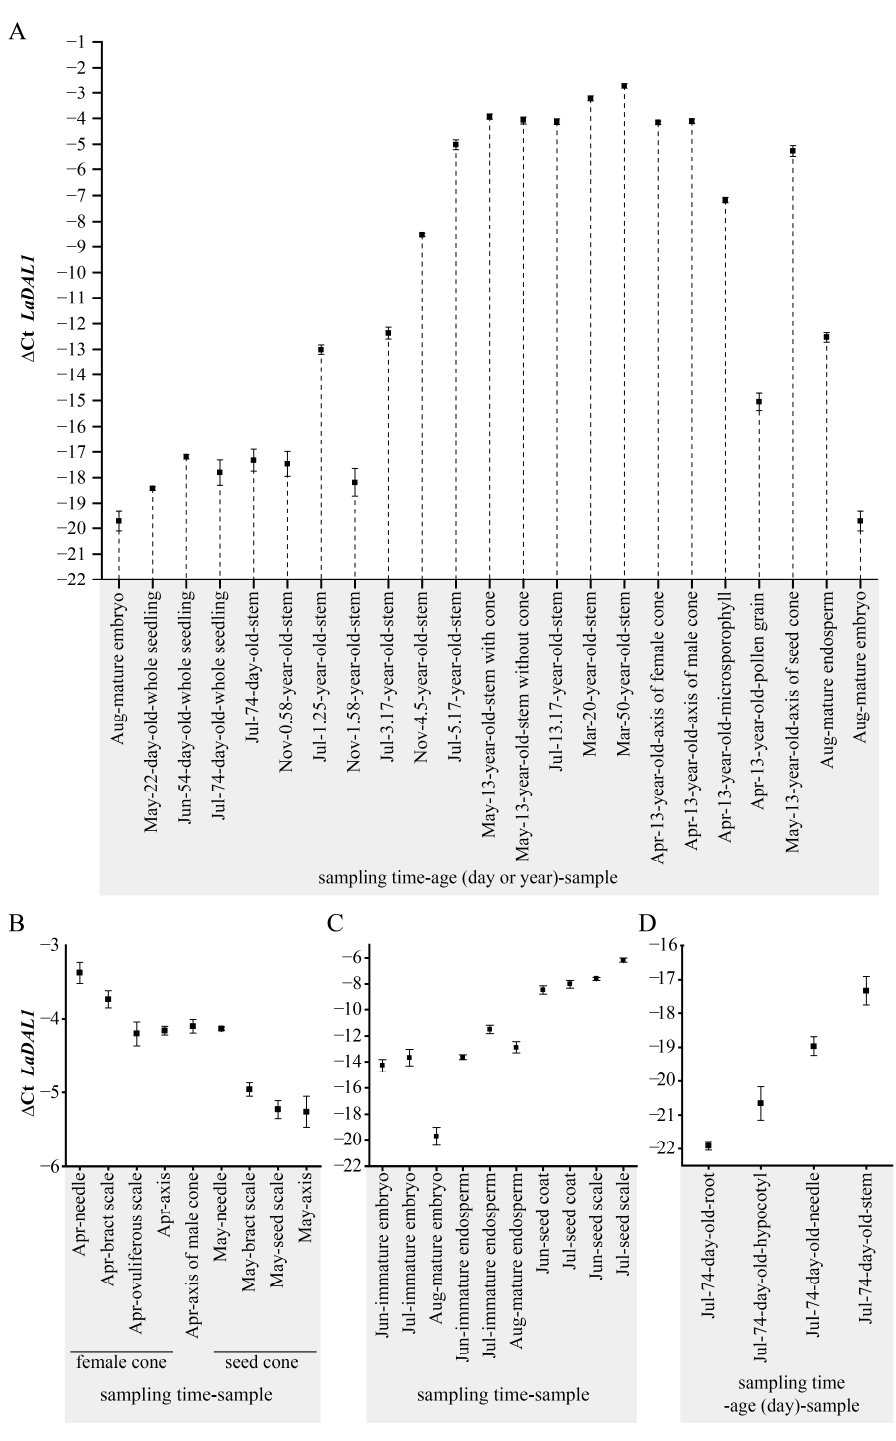
Figure 3. Dynamic spatiotemporal expression pattern of LaDAL1 in the life cycle of Larix kaempferi . ( A ) The LaDAL1 expression pattern in the L. kaempferi life cycle. Samples included the embryo and endosperm of mature seeds ( n = 10), 22-day-old seedlings ( n = 10), 54-day-old seedlings ( n = 10), 74-day-old seedlings ( n = 6), the uppermost stem from 13-year-old trees with ( n = 4) or without cones ( n = 4), the axis of male and female cones and the microsporophylls ( n ≥ 10), pollen grains (after modulation for 24 h), and the axis of immature seed cones ( n ≥ 10). These cones were collected from 13-year-old active L . kaempferi trees ( n ≥ 4). The p -value was calculated between May-13-year-old-stem with cones and May-13-year-old-stem without cones. One-way ANOVA Duncan’s test was used for statistical analysis. ( B ) Variation of LaDAL1 transcript levels in different cone tissues. Samples